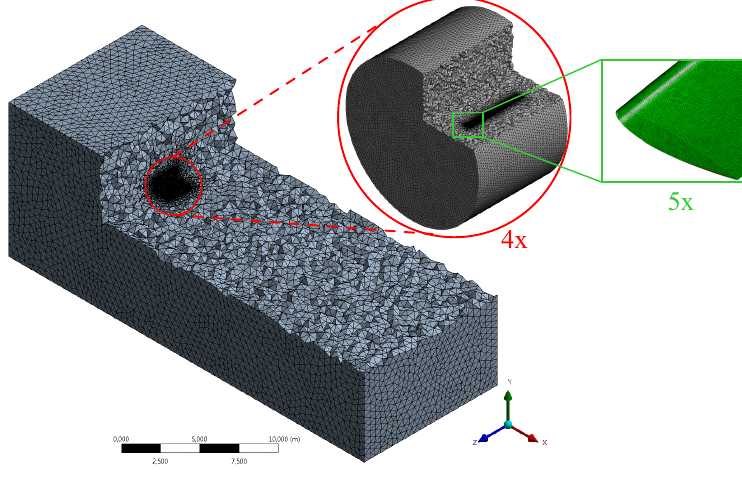
Figure 9. Three-dimensional mesh discretization.